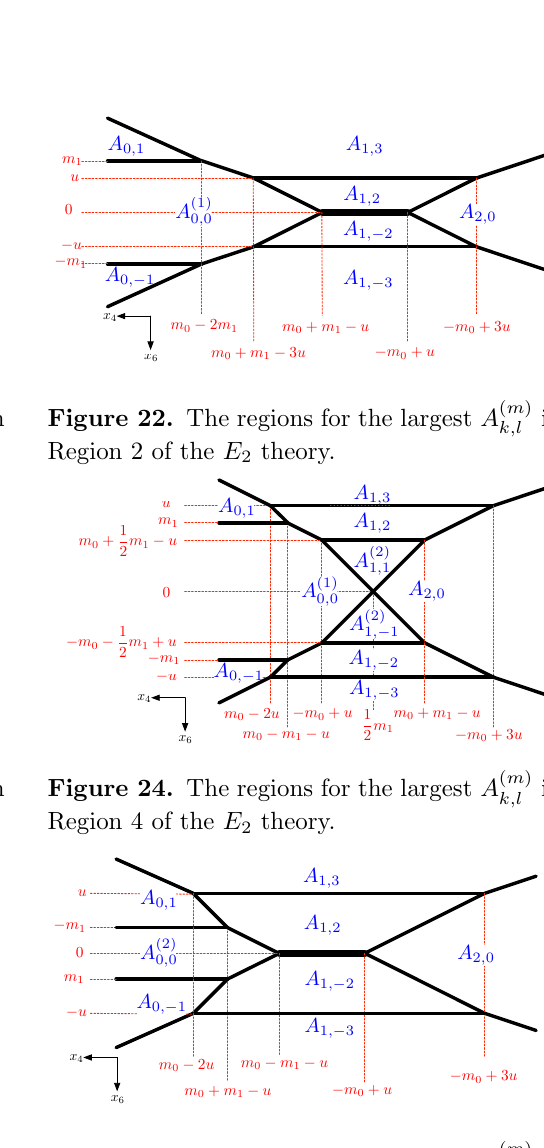
Figure 25. The regions for the largest A ( m ) Region 5 of the E 2 theory.